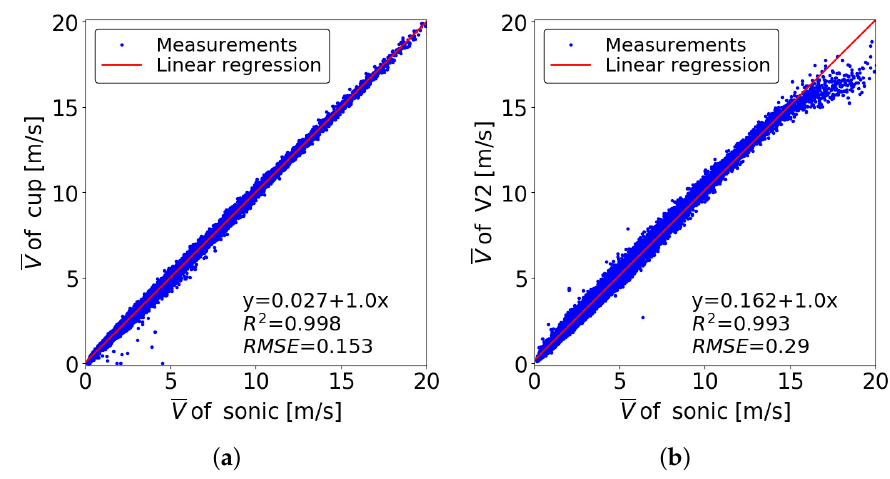
Figure 5. Comparison of 10-min average horizontal wind speeds at 40 m height. ( a ) Sonic anemometer and cup anemometer; ( b ) Sonic anemometer and V2 profiling